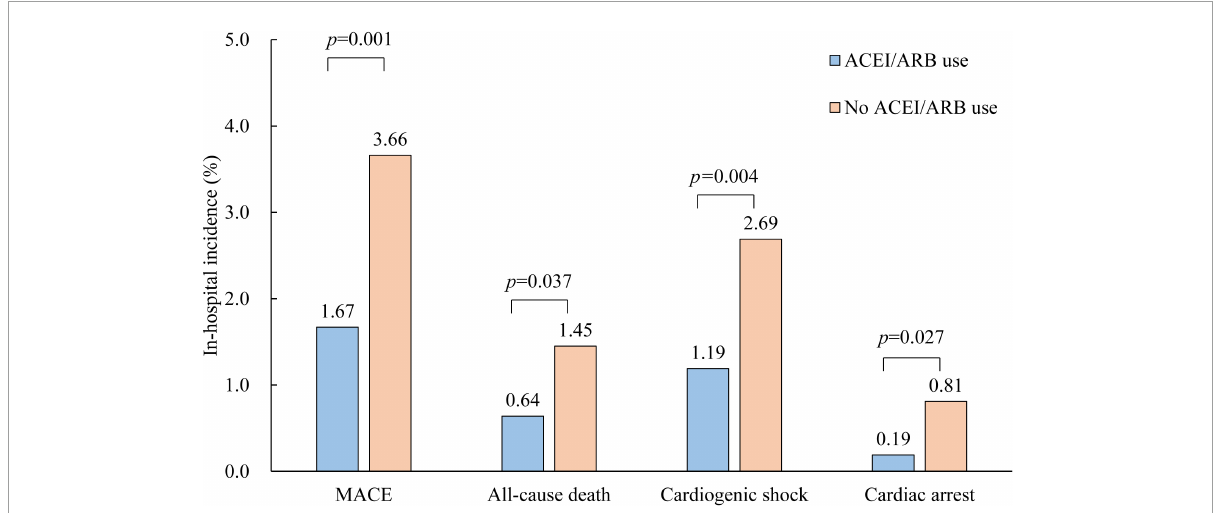
FIGURE1 Comparison of in-hospital outcomes of AMI patients with and without early ACEI/ARB use. ACEI, angiotensin-converting enzyme inhibitor; ARB, angiotensin receptor blocker.